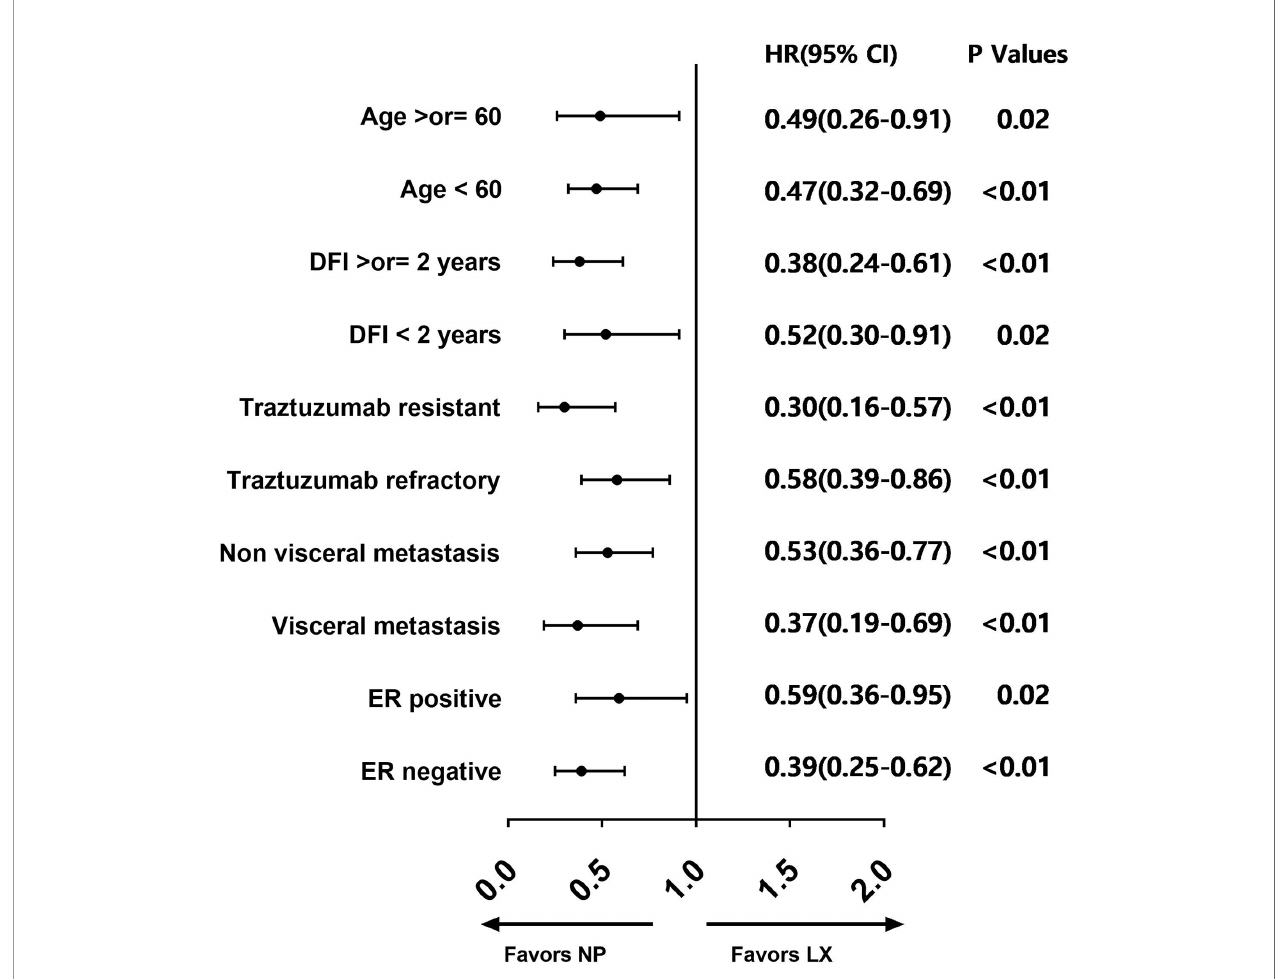
FIGURE 3 | Forest plot for subgroup